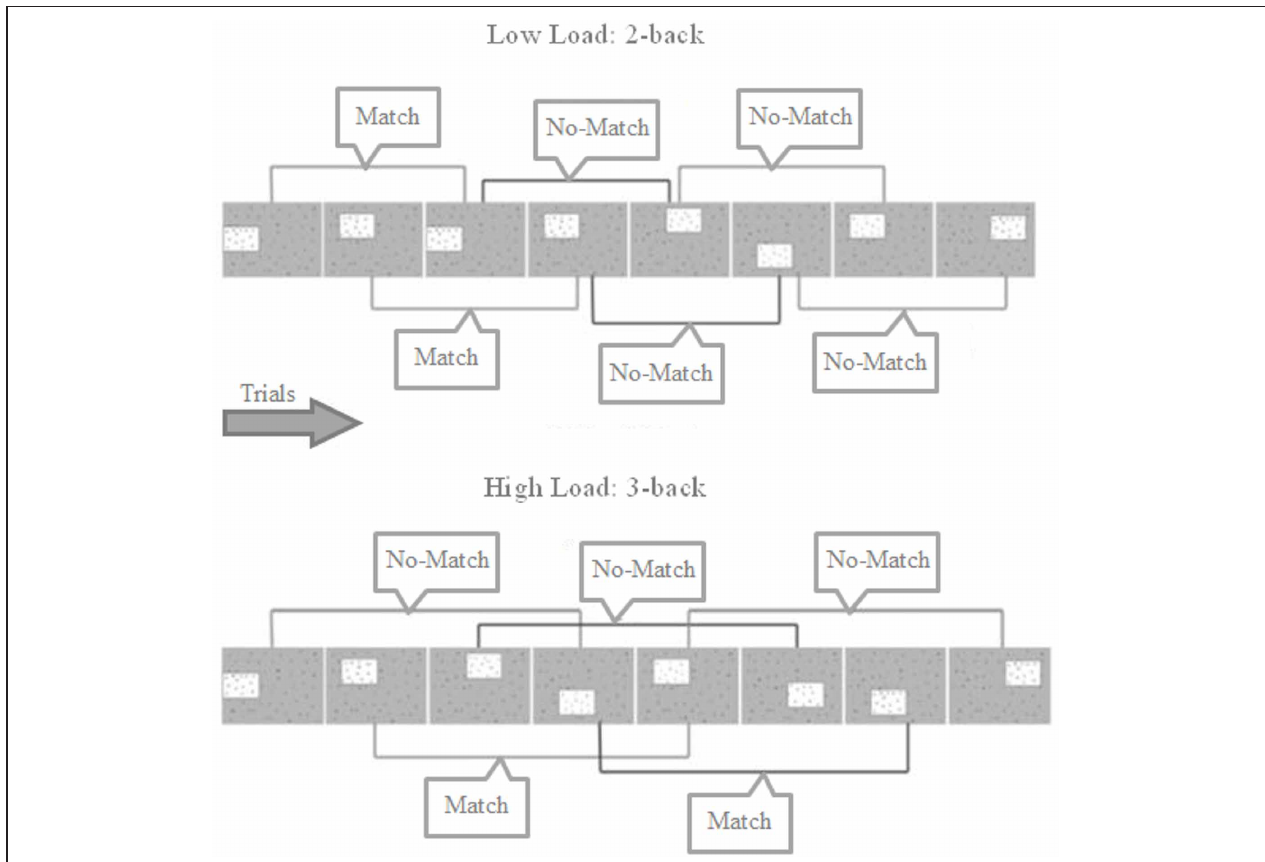
FIGURE 1 | Trial structure for 2- and 3-back blocks showing match and no-match trials. Participants must indicate whether the box is located in the same position as 2 or 3 trials previously. Each box was presented for 350ms,